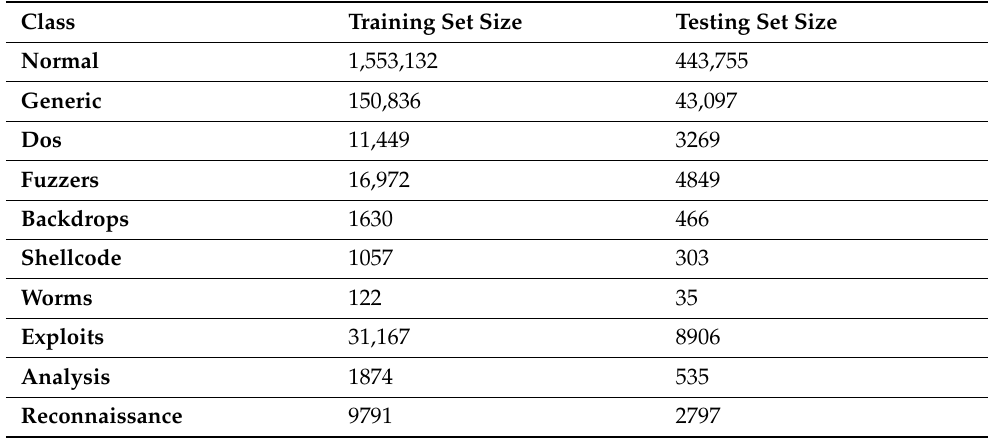
Table 4. UNSW-NB15 data samples of each